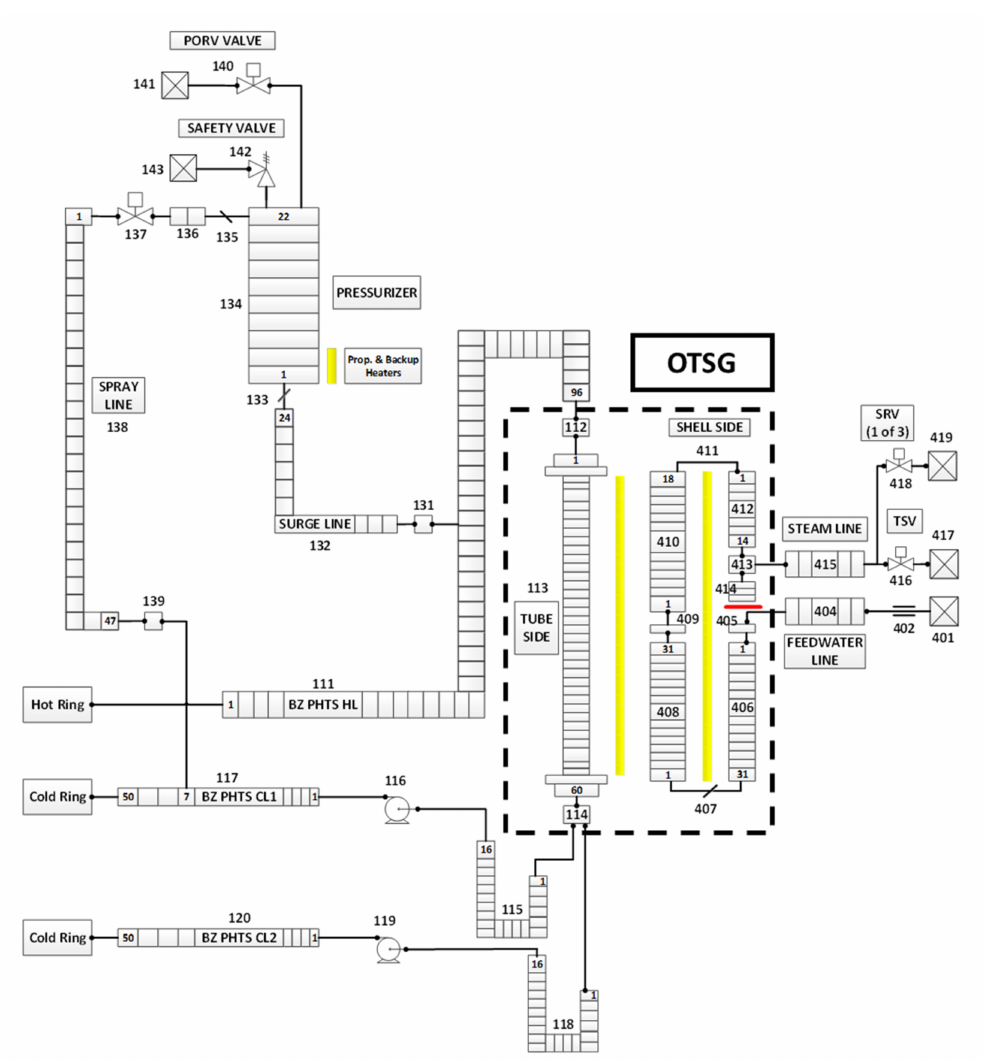
Figure 4. Schematic view of BZ PHTS model, loop one of two. Pressurizer system components are unique and connected only to the represented